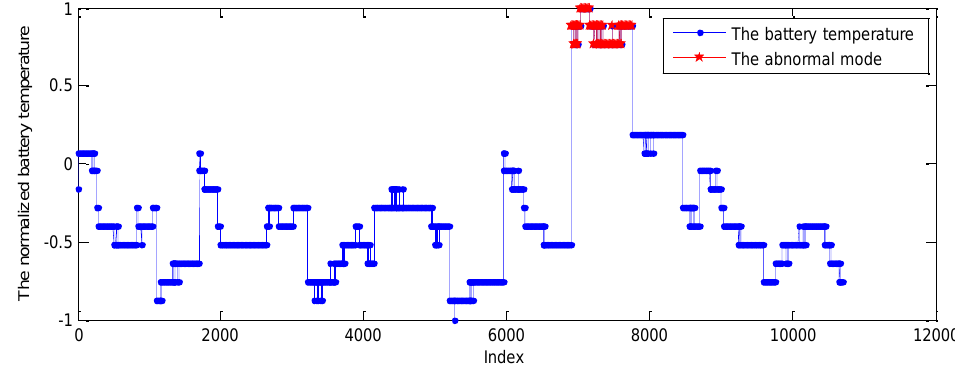
Figure 15. The battery temperature series.